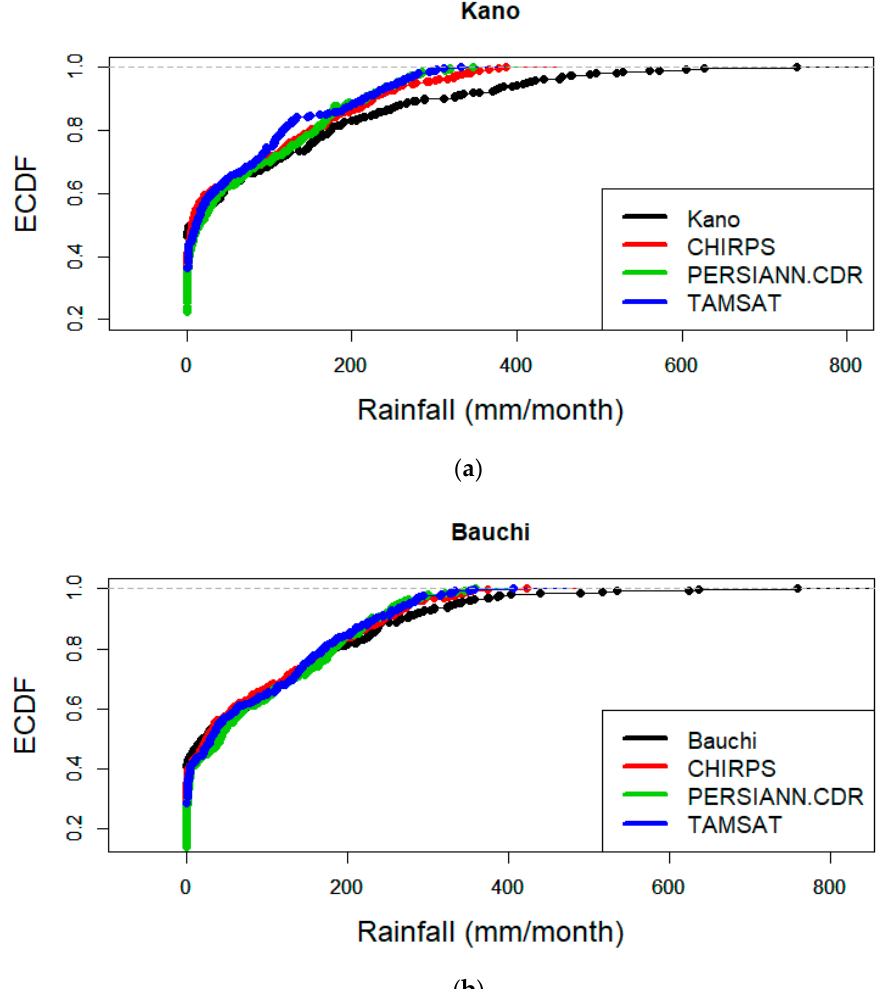
(Figure 5a) in the range of 200–400 mm / month. TAMSAT and PERSIANN exhibited